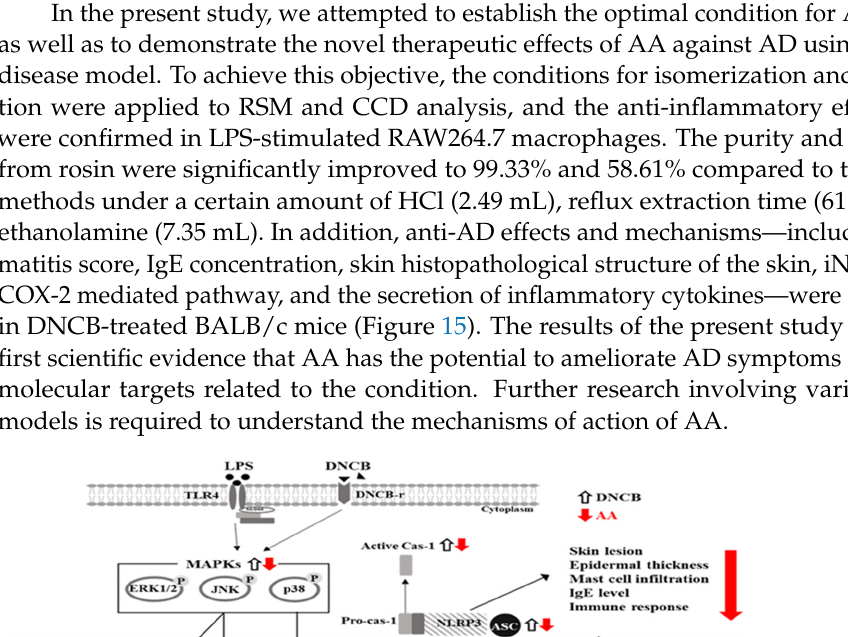
(Supplementary Table S2). RT-qPCR was performed for 40 cycles of denaturation at 95 ◦ C